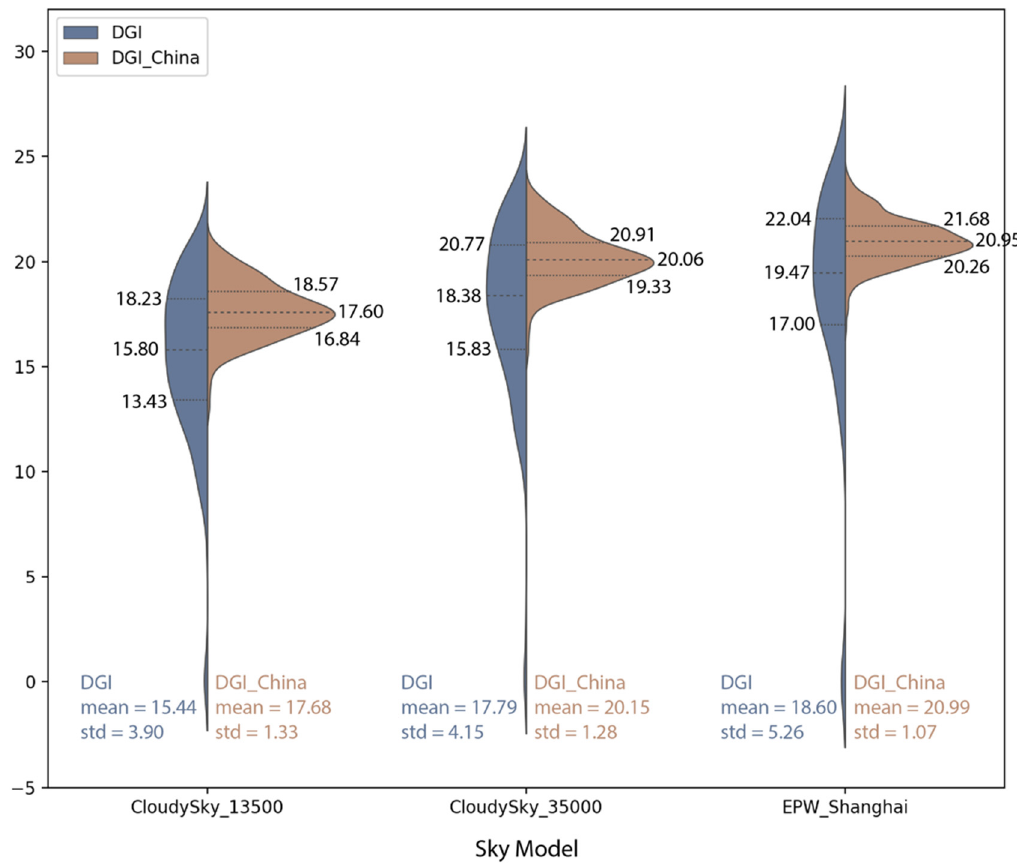
Figure 7. Comparison of Sky models on DGI and DGI China.